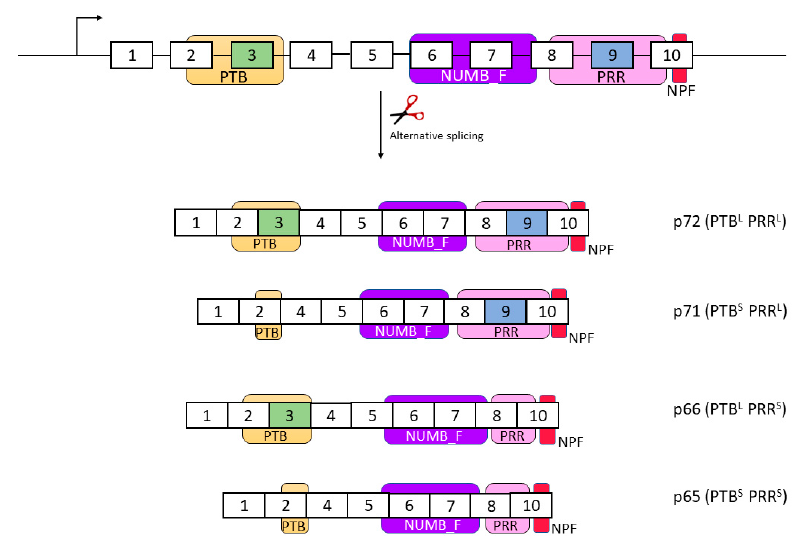
Figure 1. NUMB isoforms are generated by alternative splicing, being the PTB and PRR domains involved in this process. The resulting isoforms can be classified as having long or short PTB (PTB L/S ) and long or short PRR (PRR L/S ) domains. Please note that the sizes of exons and domains in the diagram are not to scale and are simplified for clarity.